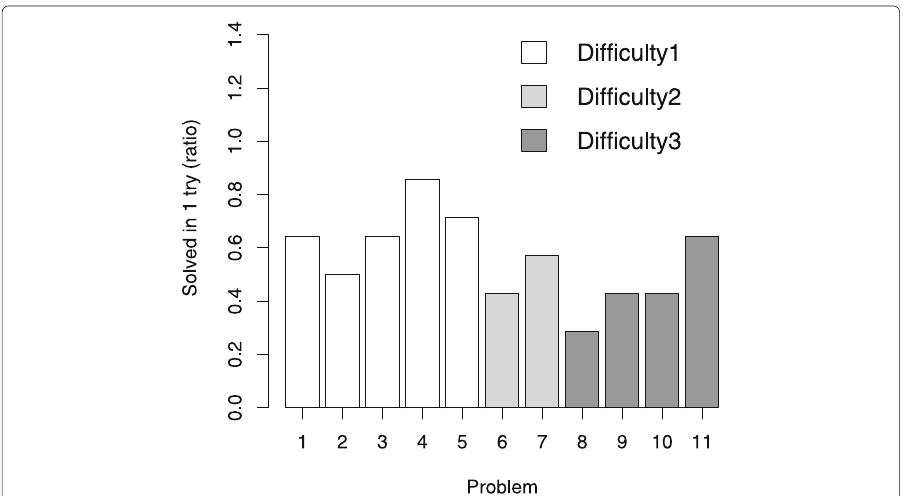
Fig. 7 Ratio of problems solved in 1 try to total number of times attempted on level 3-2